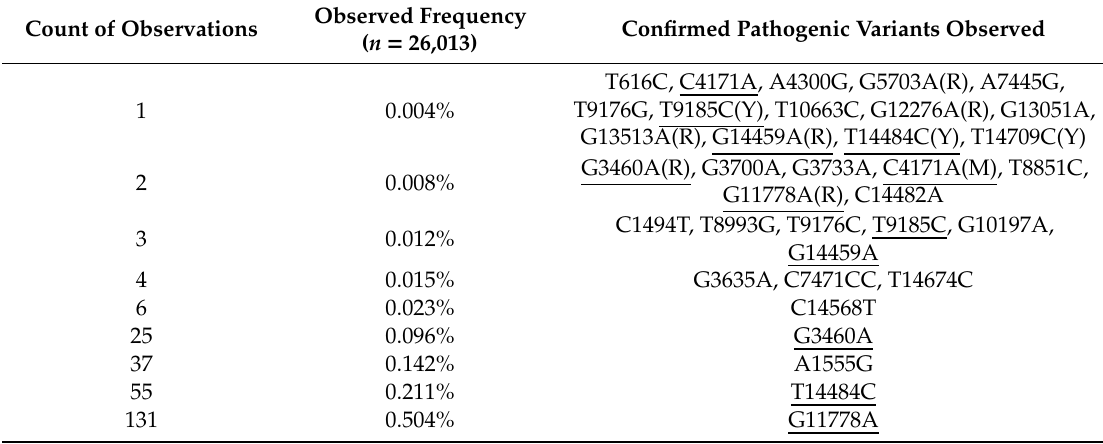
Table 2. The 29 confirmed pathogenic variants found in literature-quality mitogenomes ( n = 26,013) in the EDNAP mtDNA Population Database (EMPOP) [13]. Heteroplasmic states are indicated in parentheses with the corresponding IUPAC code. Pathogenic variants that were observed in both homoplasmic and heteroplasmic states are